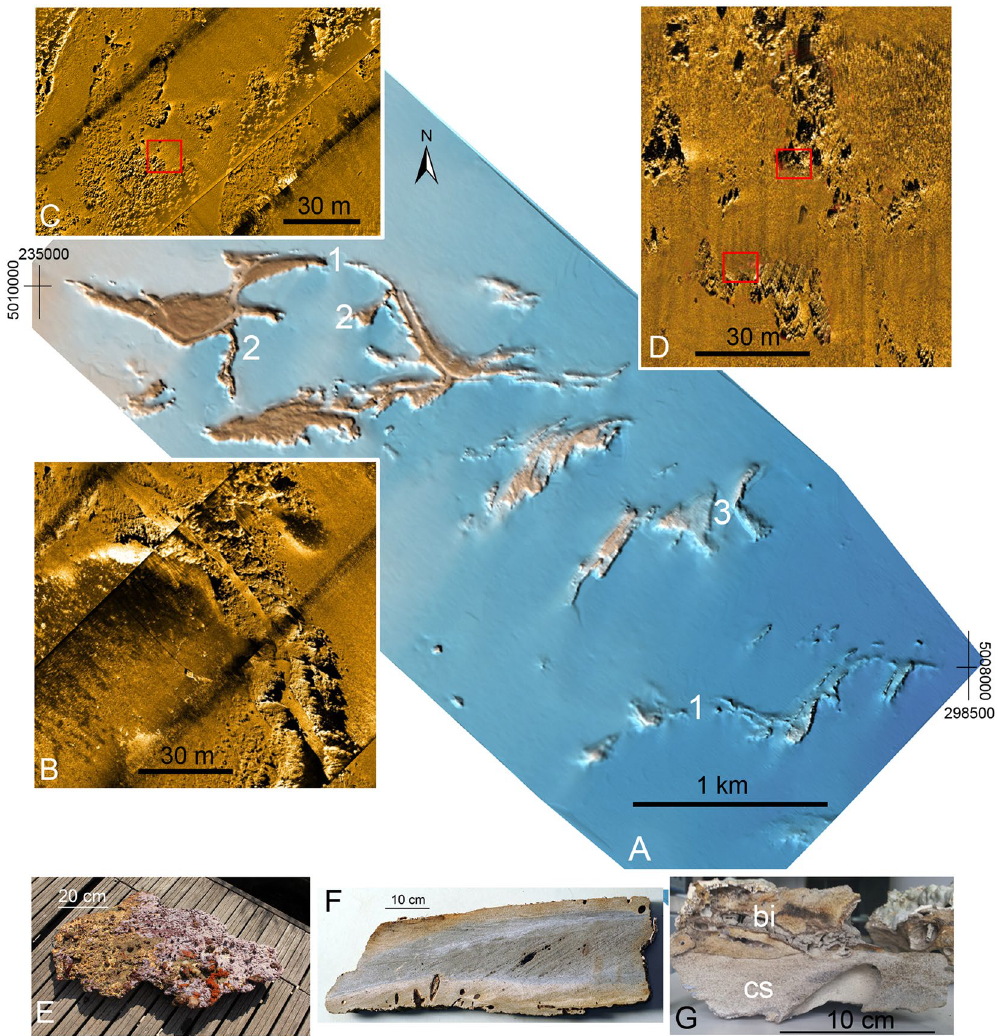
Figure 2. ( A ) Shaded relief map obtained by swath bathymetry (UTM 33N WGS84) (see location in Fig. 1). The water depth are between 17 and 25 m and bio-concretionned rocky buildups rise up to 3–4 m from the sandy sea bottom. Meandering-like horizontal paths (1) fan-like features (2), arc-shaped features (3). ( B , C and D ) Side Scan Sonar images showing examples of bio-concretionned rocky buildups morphologies. ( E ) top of the cemented shell-rich layer found at the seafloor (sampling location: bottom red square in ( D ). ( F ) Cemented sand sample (sampling location: bottom red square in ( C ). ( G ) Sample of tegnùe highlighting bio-concretions (bi) with the cemented sand layer (cs) at the bottom (sampling location: upper red square in ( C ). Additional images of cemented sand samples are in Supplementary Material Figure